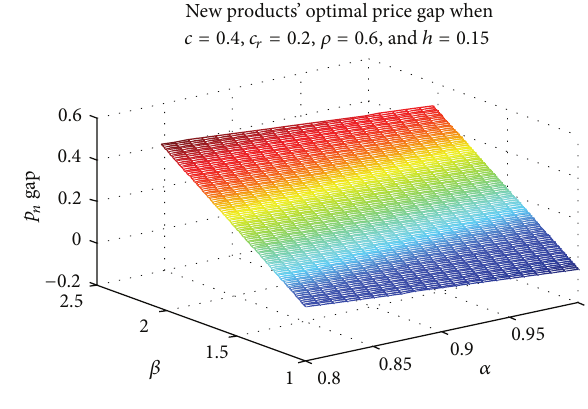
Figure 3: Consumers’ perceived value impact on Δ𝑝 𝑛 .